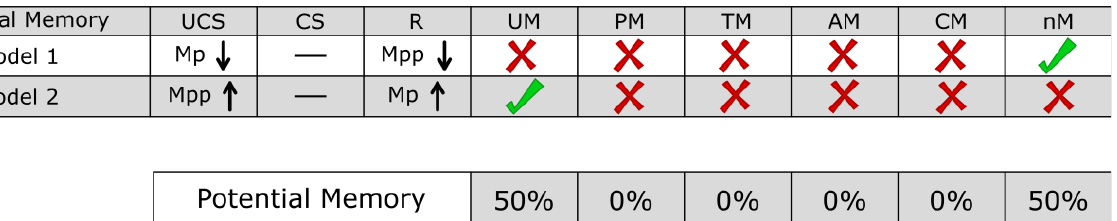
Figure 3. Example network and memory evaluation. ( A ) Two potential memory models derived from the sample biological network [75]. On the left, a UCS and R pairing that show no memory. The UCS (Mp) is stimulated (downregulated) during the grey training period and R (Mpp) is similarly downregulated. However, when the stimulation stops R reverts to its original behavior in the test period (green). On the right, the same network, but a different permutation of the UCS and R pairing which demonstrates memory. The UCS (Mpp) is stimulated (upregulated) and R (Mp) shows a response from its baseline behavior. However, when stimulation is halted (green test period), the behavior of R has continued to rise, rather than returning to baseline. Therefore, we conclude that this circuit shows a form of memory consistent with our functional definition—the behavior of R has been specifically modulated by past experience via stimulation of the UCS. ( B ) A cartoon representation of how potential memory models are evaluated using the example from ( A ). In this biological model, only two potential memory models passed the pretest and of those only one showed any memory (50%).